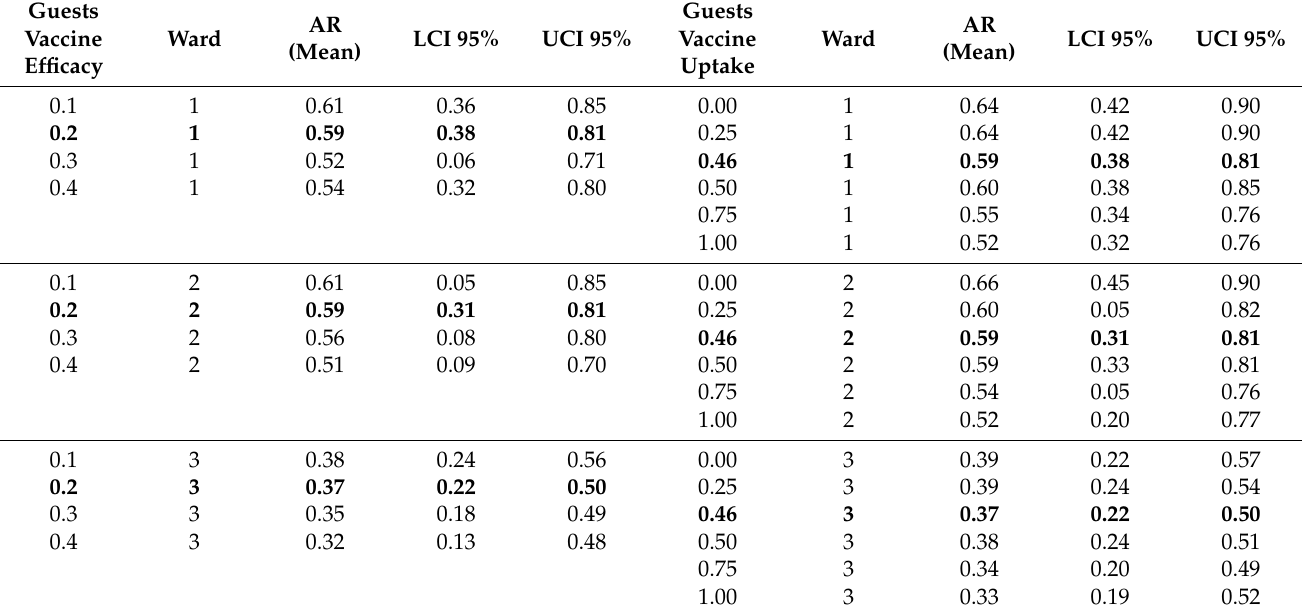
Table 3. Results of the simulations: Guests vaccine efficacy and vaccine uptake parameters. The values belonging to the baseline scenario are reported in